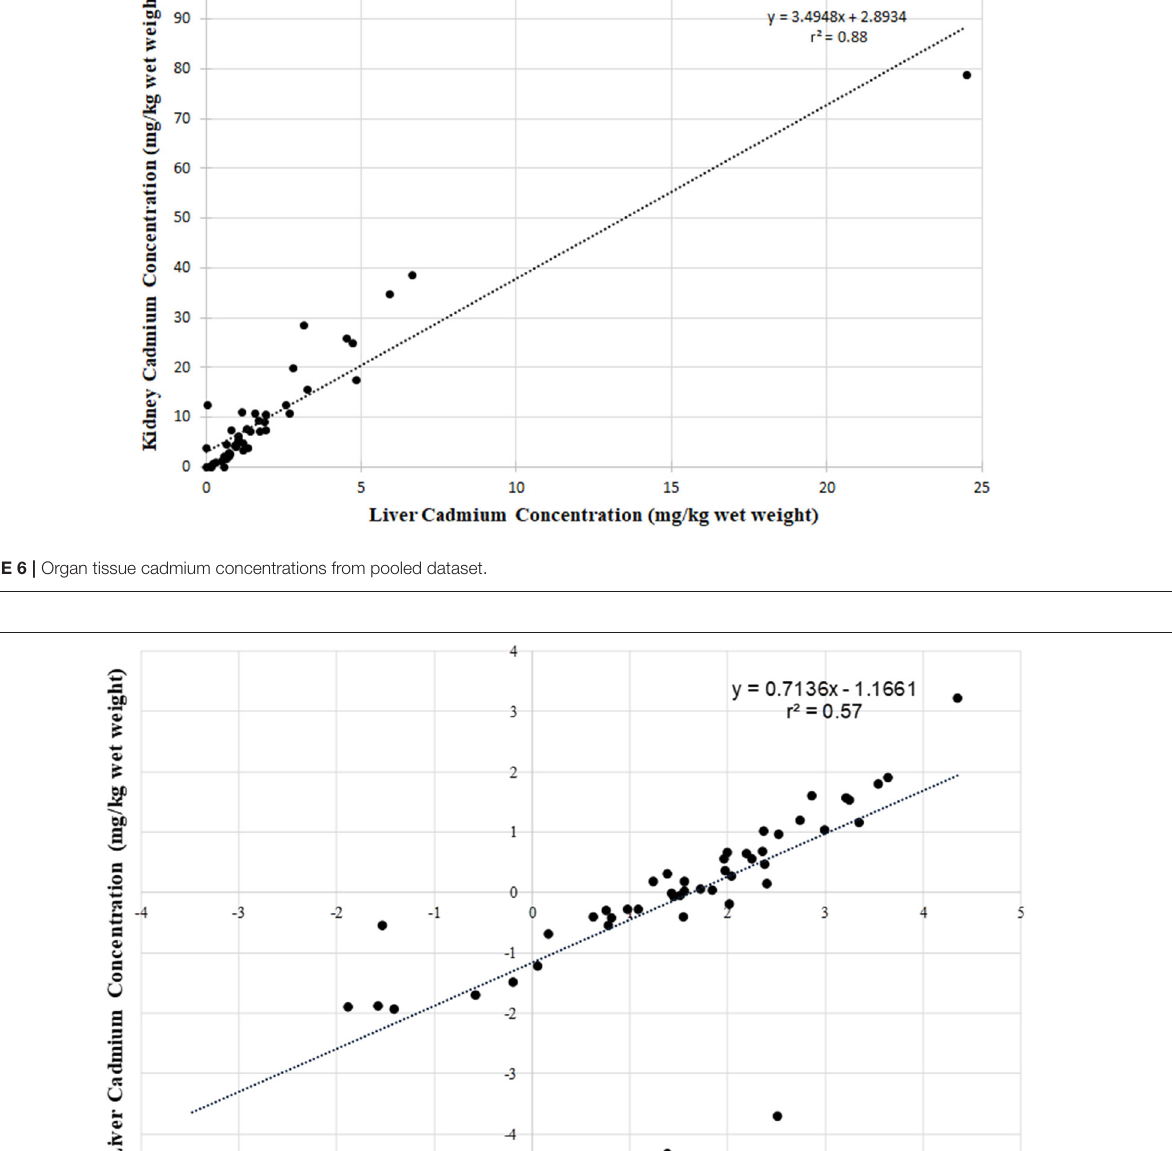
below 3.1 mg/kg. For cadmium liver concentrations of ≤ 2.4 mg/kg, the HQ value is below 1.0 for a consumption rate of 23 g/day of liver (FNFNES heavy consumer). Eleven of 48 liver samples had cadmium concentrations below 2.4